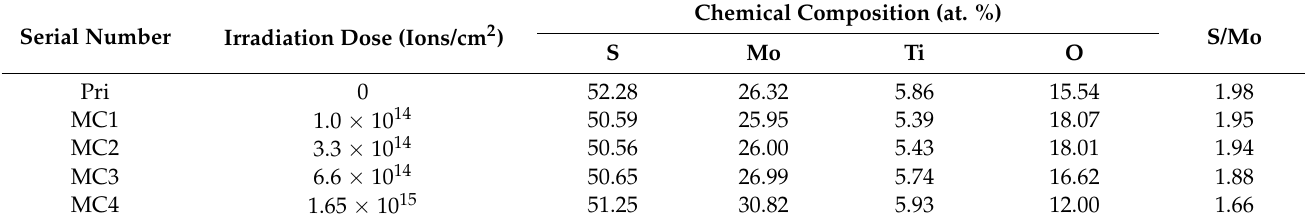
Table 1. The chemical compositions of the film before and after irradiation. Chemical Composition (at.